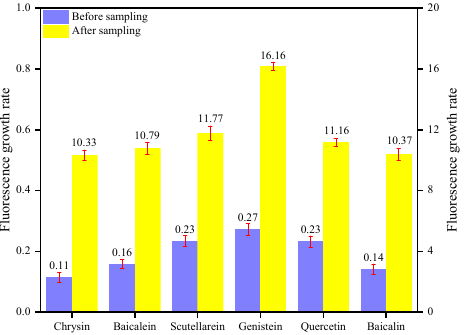
Figure 8. Fluorescence enhancement rate of active molecular film after outdoor Figure 8 . Fluorescence enhancement rate of active molecular film after outdoor sampling.